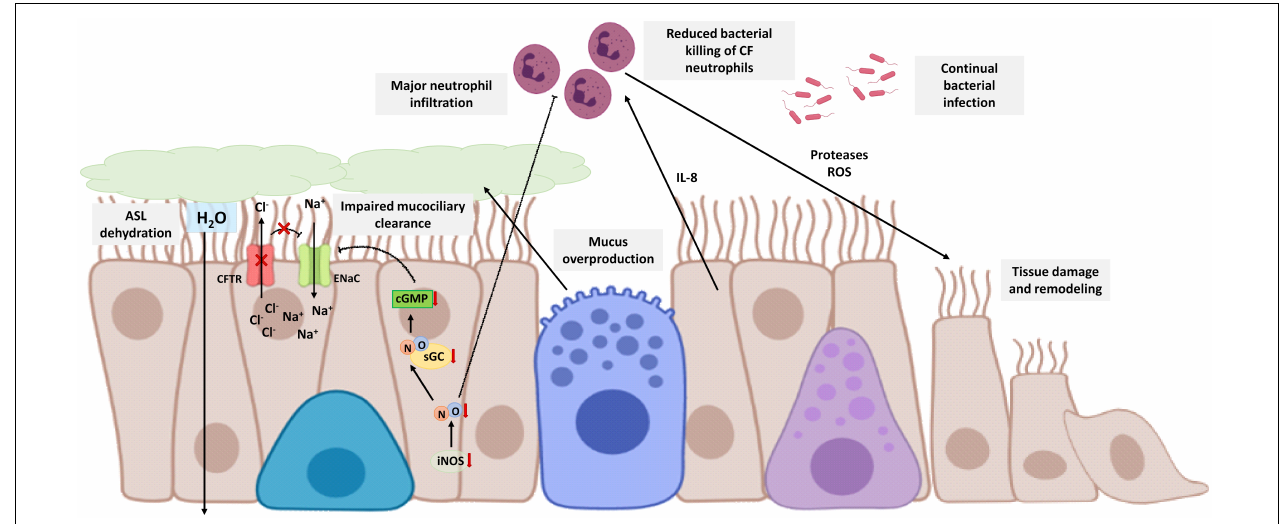
FIGURE 5 | Schematic view of CF bronchial epithelial cells and neutrophilic inflammation. CFTR defective protein results in mucus overproduction, a decrease of chloride-ion transport, and an increase of sodium transport through the no inhibition of ENaC. Therefore, there is dehydration and reduction of ASL that affects mucociliary clearance. CF epithelial cells express lower levels of iNOS in comparison with healthy epithelial cells and consequently suboptimal cGMP levels that contribute with the no inhibition of ENaC. On the other hand, the disability of the mucociliary clearance is related to continual bacterial infection. Bronchial epithelial cells secrete cytokines, such as IL-8, that recruit neutrophils to bronchi and bronchioles. Neutrophils are CFTR defective with reduced bacterial killing, worsening the disability of the mucociliary clearance, and chronically releasing proteases and ROS that contributes to airway tissue damage and remodeling. NO reduces the sequestration of polymorphonuclear leukocytes so that lower levels of NO contribute to the major neutrophil infiltration. The image has been created with